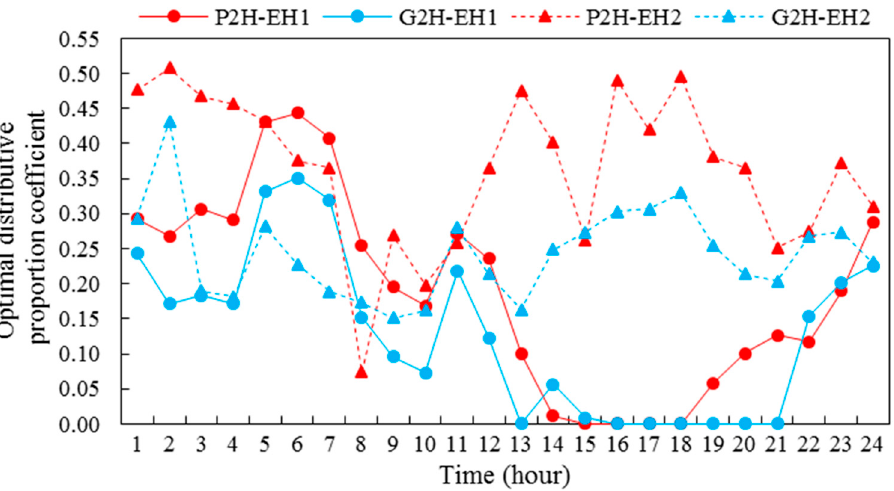
Figure 7. Change of optimal distributive proportion coefficient for EH1 and EH2.